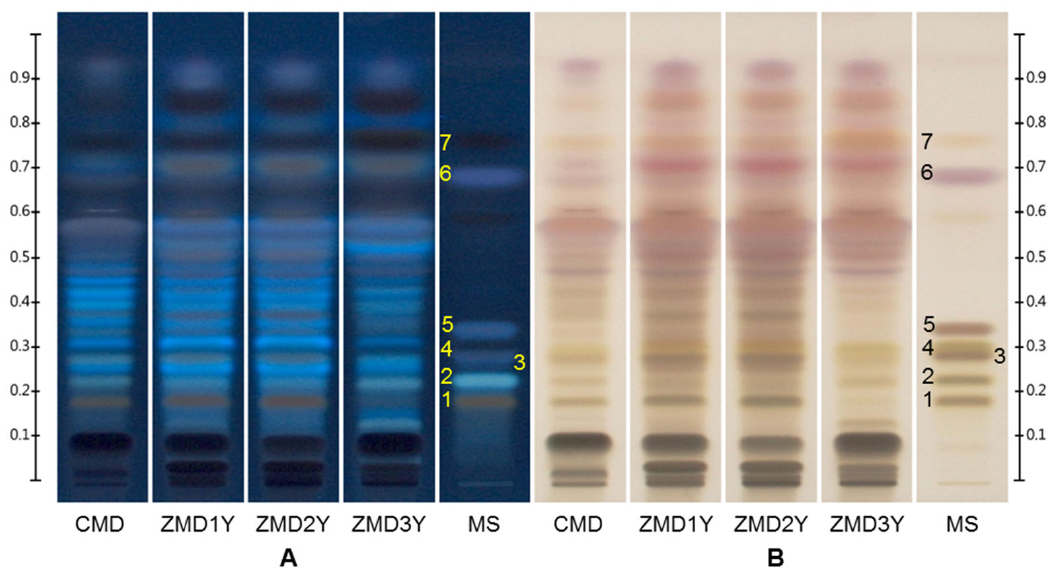
Figure 2. Typical HPTLC chromatograms of mixed standards and Ophiopogonis Radix samples analyzed by two step gradient elution with two mobile phases. Plates were sprayed with 10% sulfuric acid in ethanol solution and viewed under UV 366 nm ( A ) and white light ( B ). CMD:CMD (one-year-old); ZMD 1Y: one-year-old ZMD; ZMD2Y: two-year-old ZMD; ZMD3Y: three-year-old ZMD; MS: mixed standards. 1. ophiopogonin D (R f 0.18), 2. ophiopojaponin C (R f 0.23), 3. ophiopogonin